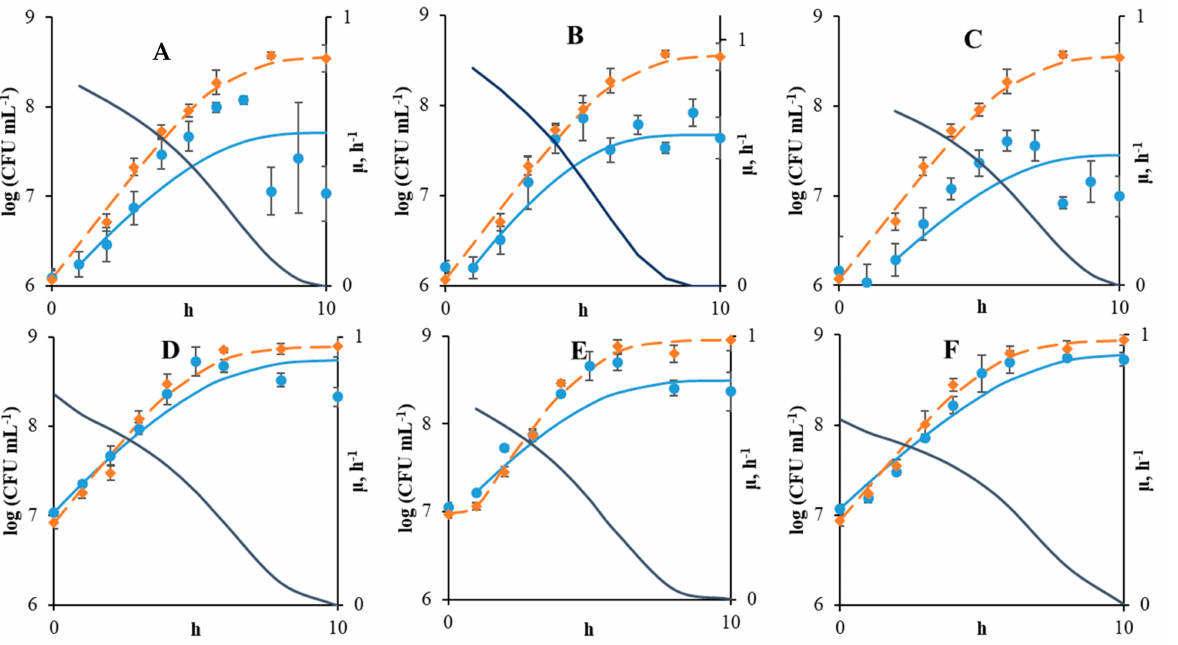
Figure 2. The experimental and calculated curves of S. aureus growth in monoculture (orange) and coculture (blue) at different initial cell counts (( A – C )- x Pt = 10 6 CFU mL − 1 ; ( D – F )- x Pt = 10 7 CFU mL − 1 ) and with different substrates (( A , D )- 0 0 glucose; ( B , E )-FOS; ( C , F )-lactulose). The curves of the calculated specific growth rates of the pathogen as a function of time (dark blue). To calculate the specific growth rate of the pathogen, the count of bifidobacteria was determined according to the exponential law. The concentration of lactic and acetic acids were defined using the yields values. To calculate the specific growth rate MIC equation was used. The growth curves were built using the calculation results from the MIC model in coculture and the Verhulst equation in